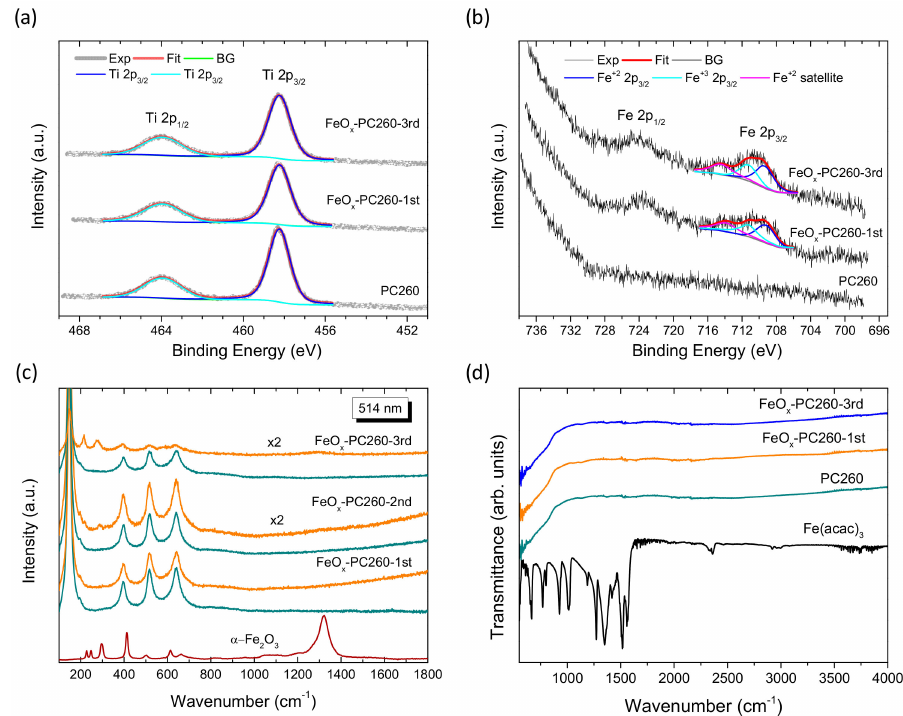
Figure 3. ( a ) Ti 2p and ( b ) Fe 2p core level for the pristine and surface modified FeO x –PC260 films after the 1st and 3rd CC cycle. Solid lines correspond to the total fit and the individual peaks of the Ti 2p and Fe 2p 3/2 spectral deconvolution. ( c ) Raman spectra of the FeO x –PC260 films for the different CC cycles before (green) and after (orange) laser annealing in comparison with a reference hematite spectrum at 514 nm. ( d ) ATR-FTIR spectra of the neat Fe(acac) 3 precursor, PC260, and FeO x –PC260 after the 1st and 3rd CC